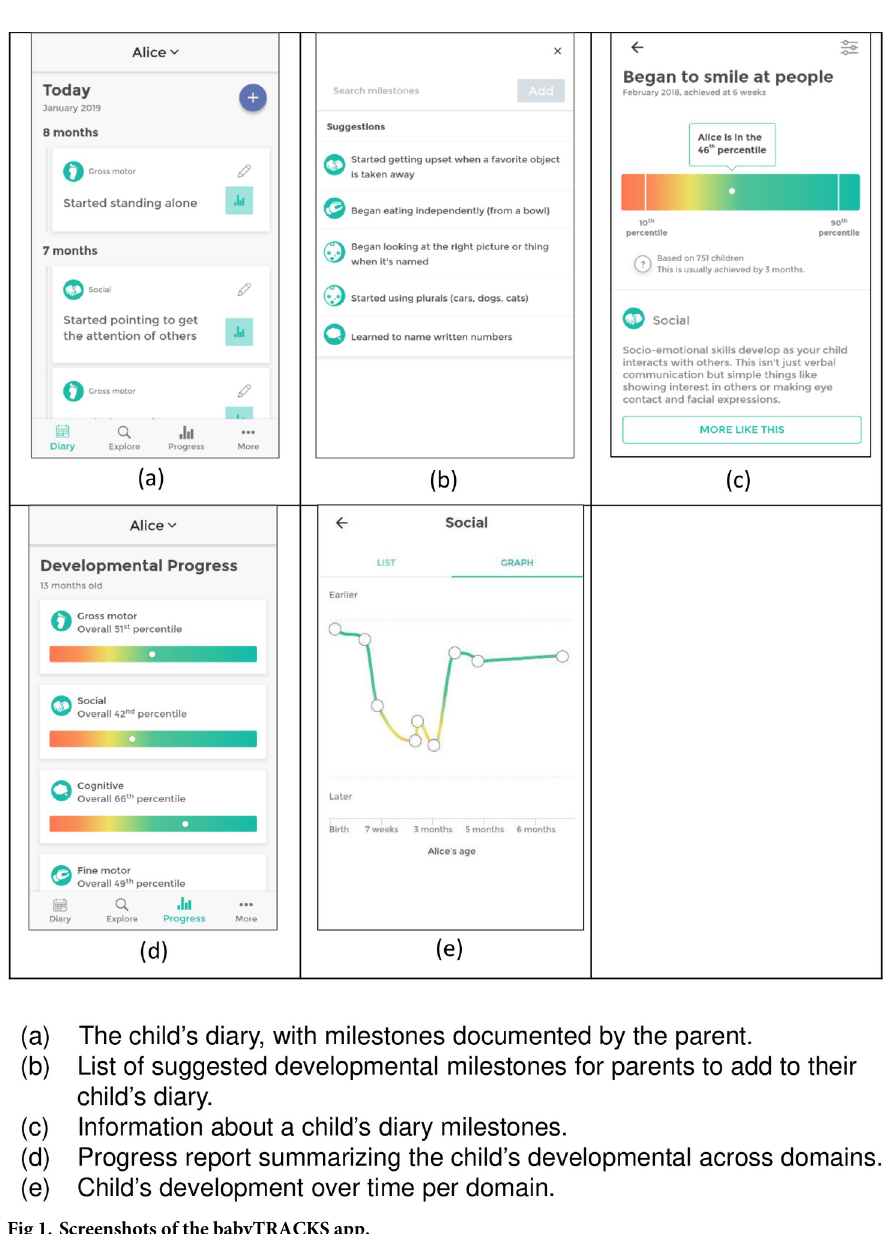
Fig 1. Screenshots of the babyTRACKS